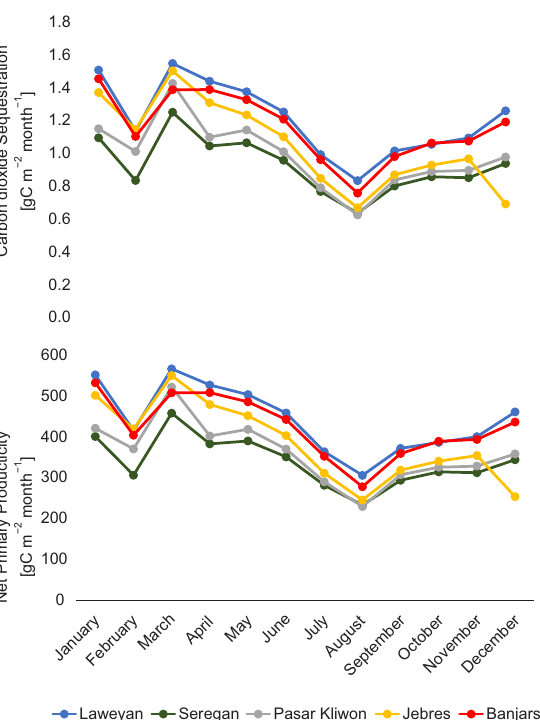
Fig. 10. (A) Temporal variation of carbon dioxide sequestration and (B) net primary productivity (NPP) in each district of Surakarta